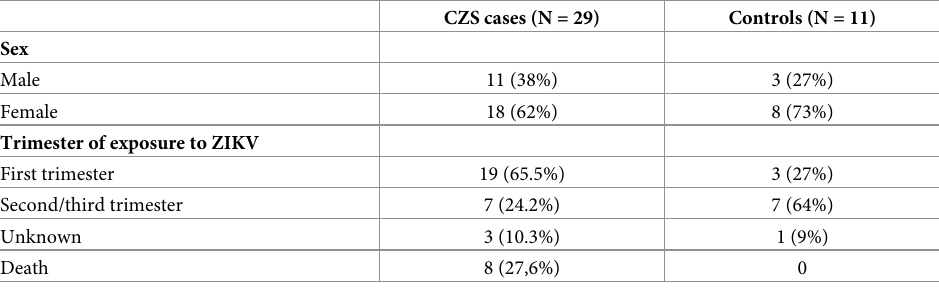
Table 1. Clinical and demographic characteristics of the study